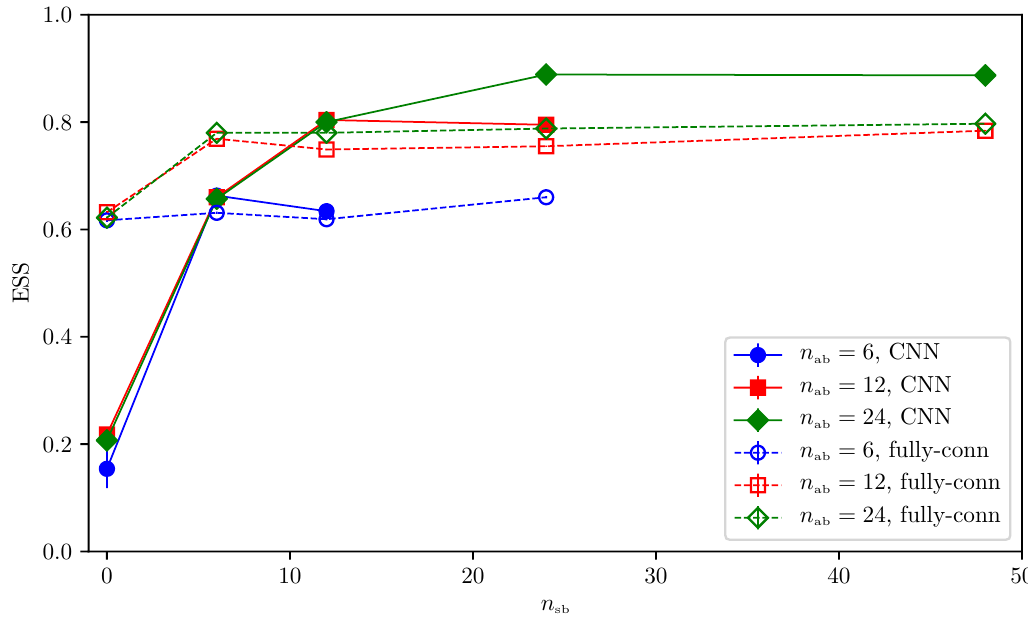
Figure 4 . Comparison of ESS for stochastic normalizing flows, with fully connected neural net- works (empty symbols) and with CNN (full symbols), for varying number of affine blocks n ab and stochastic blocks n sb . Results obtained for 16 × 8 lattices at κ = 0 . 2 , λ = 0 . 022 . Training duration is 10 4 epochs for SNFs with CNN and 5 × 10 4 for SNFs with fully connected networks. little to no improvement when more stochastic blocks are inserted, while CNN-based flows improve with increasing n at a similar rate even for larger sb